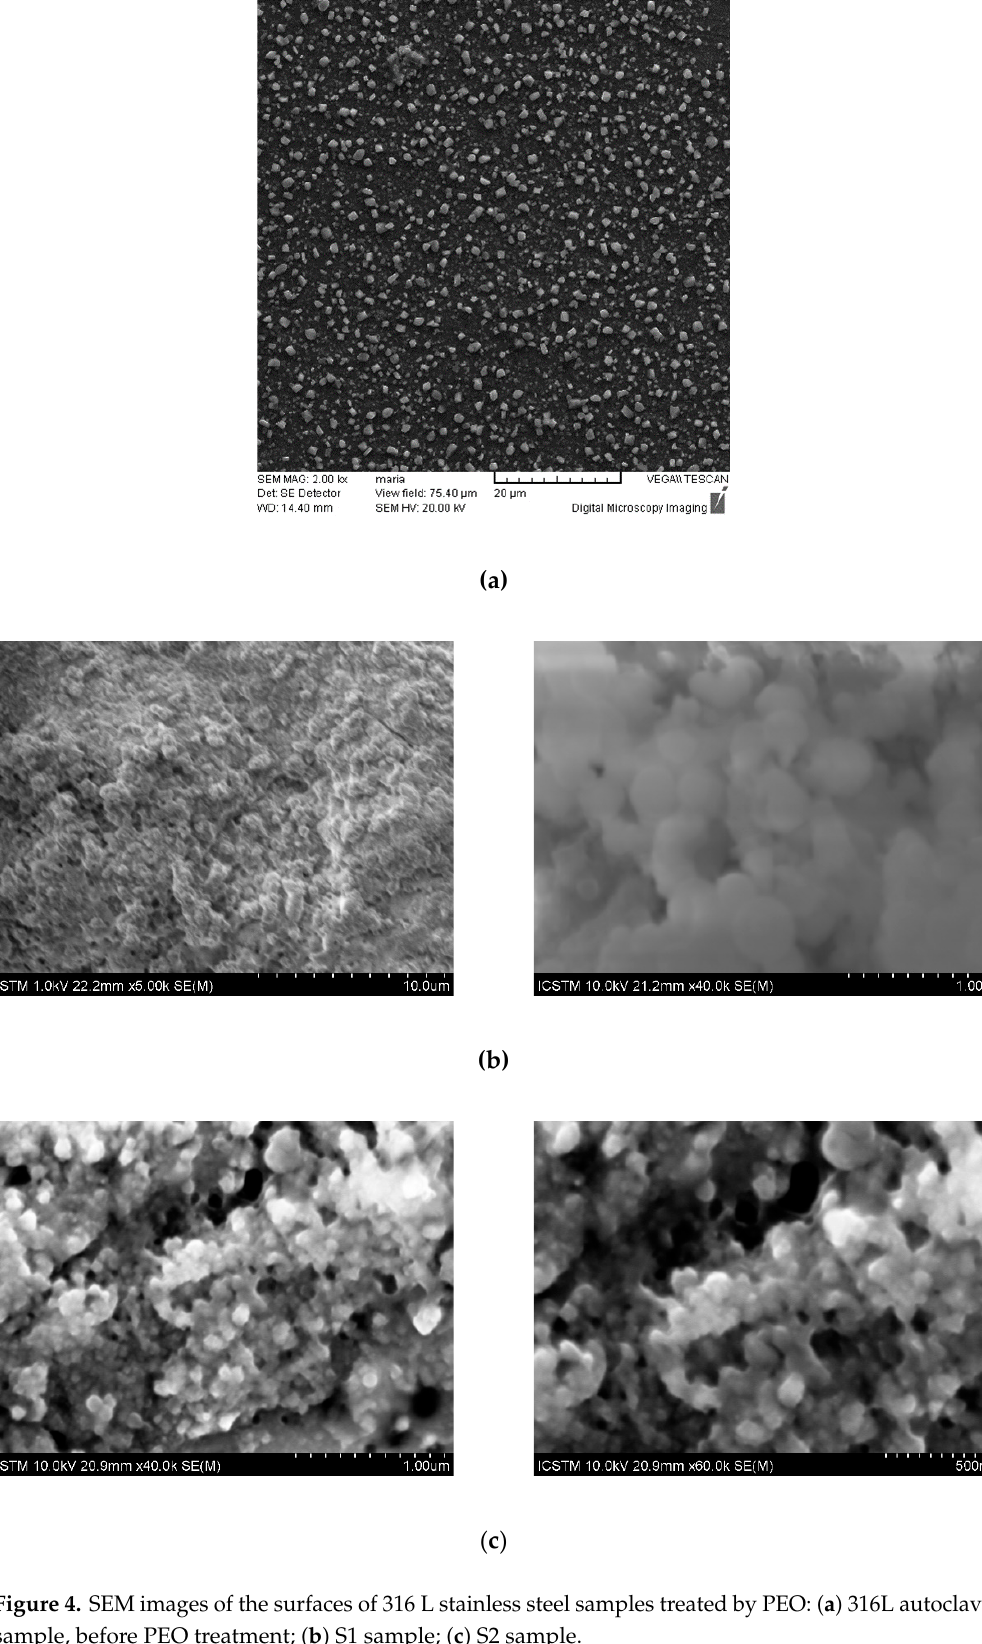
Figure 4. SEM images of the surfaces of 316 L stainless steel samples treated by PEO: ( a ) 316L autoclave sample, before PEO treatment; ( b ) S1 sample; ( c ) S2 sample.